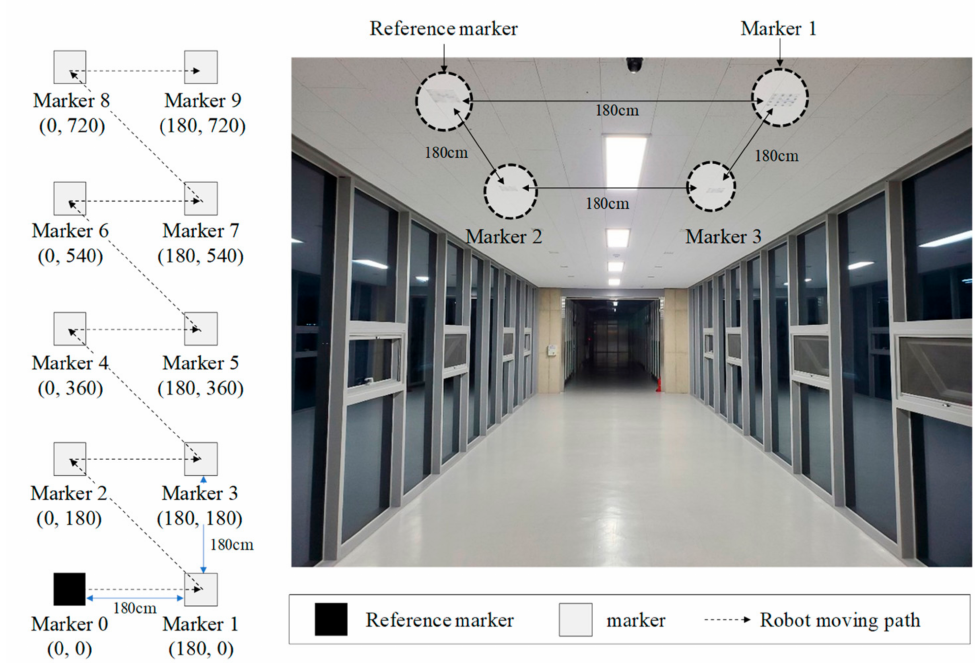
Figure 14. Test setup to verify method of calculating marker position. In addition, tests were performed to move markers and add new markers considering the frequent movement of markers or the use of additional markers owing to the expan- sion of the region. Figure 15 shows the test conditions for predicting marker movement. The position of marker 4 was changed from (0, 360) to (60, 420) in the global coordinate system, and the position of marker 5 was changed from (180, 300) to (180, 360).